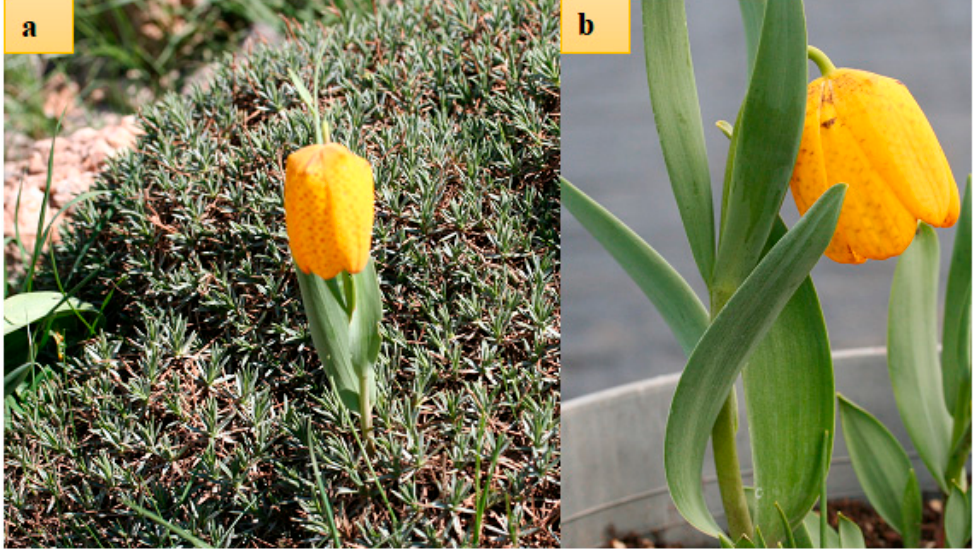
Figure 1. A view from in-situ ( a ) and ex-situ ( b ) habitat of F. aurea (original photo by M.